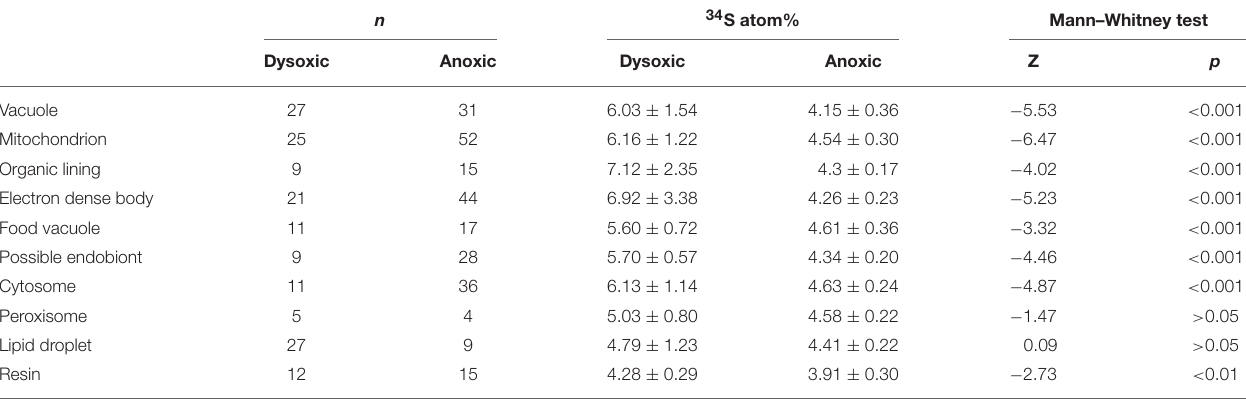
TABLE 2 | Results of Mann–Whitney test of 34 S atom% between dysoxic and anoxic